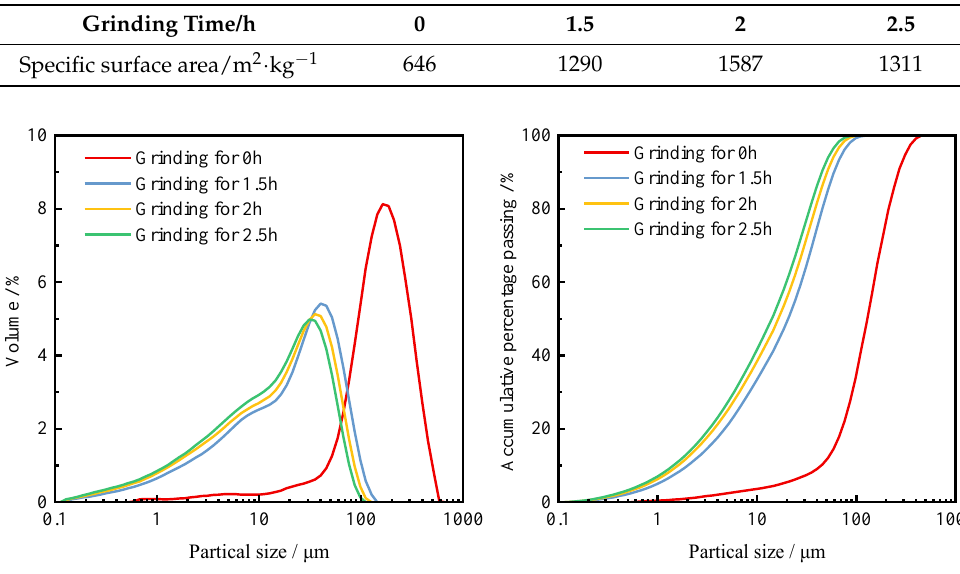
Figure 5. Particle size distribution and cumulative sieve allowance of IOTs at different grinding times. Table 3. Specific surface area of IOTs at different grinding times.